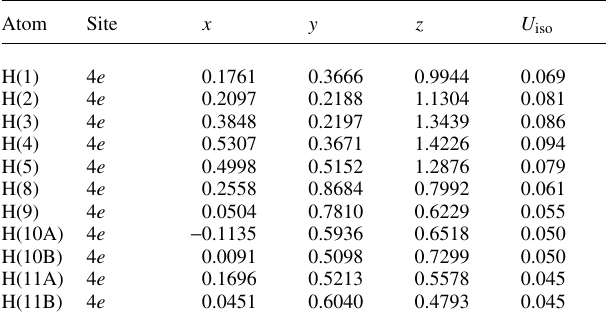
Table 2. Atomic coordinates and displacement parameters (in Å 2 ) .